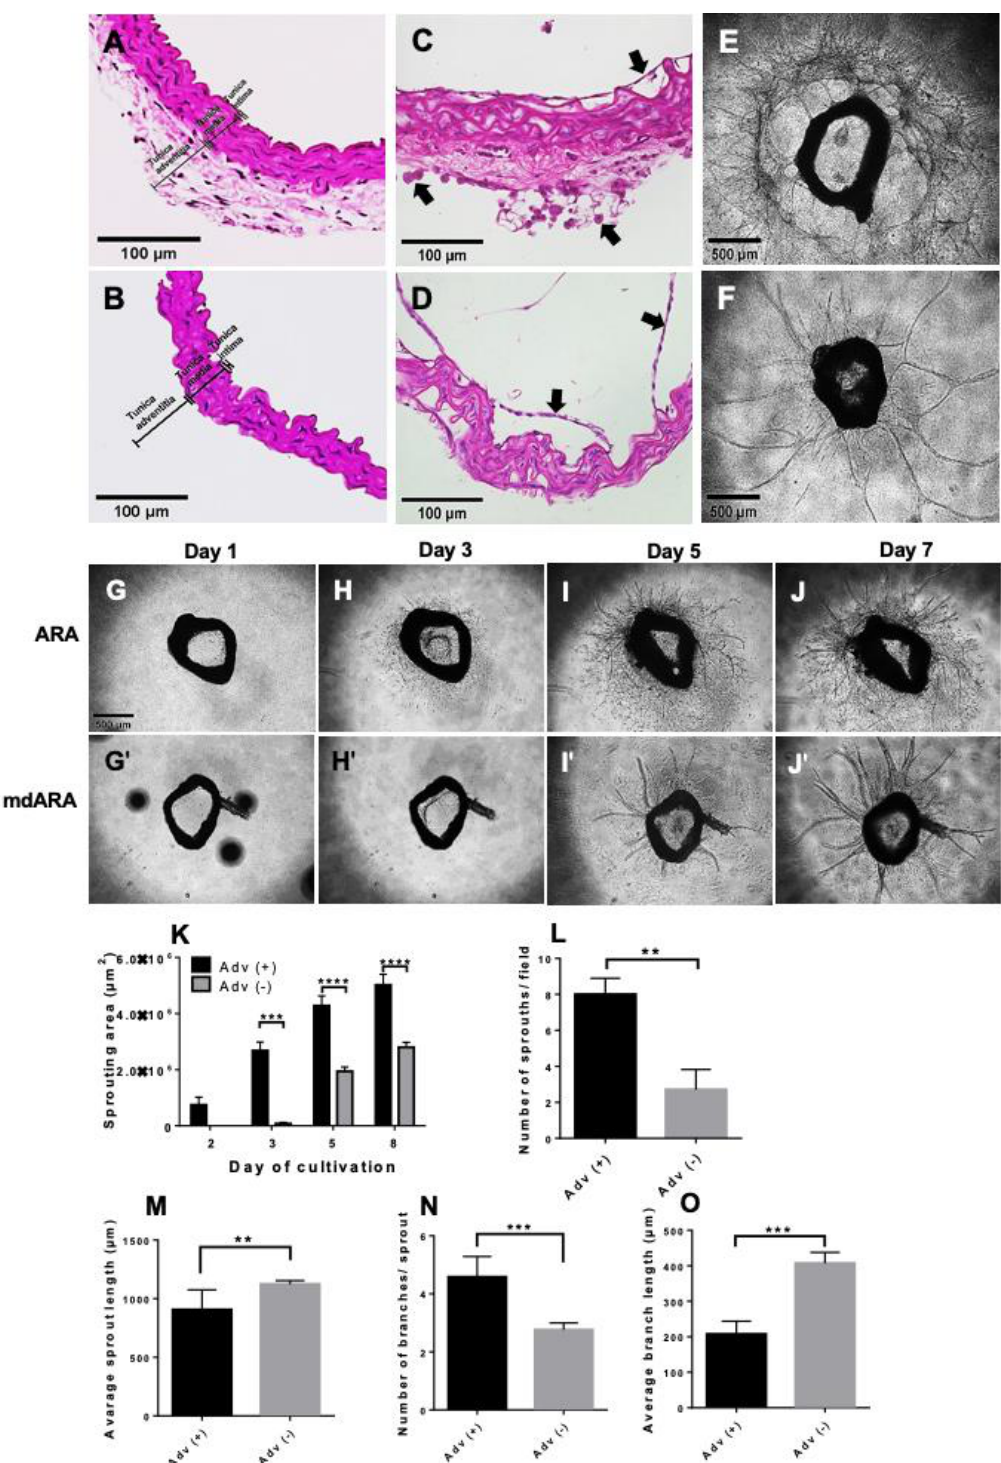
Figure 2. Removal of the adventitia delays sprouting and modulates the sprouting pattern in ARA. H&E stained paraffin sections of freshly isolated mouse aorta embedded with ( A ) and without adventitia ( B ). ARA and mdARA after 7 days of cultivation: sprouting originated from the intima, but also from the adventitia (arrows) ( C ), in mdARA only from the intima ( D ). Phase contrast images of ARA ( E ) and mdARA ( F ) after 7 days of cultivation. Time course of sprouting and branching in ARA ( G – J ) and mdARA ( G’ – J’ ). In the absence of adventitial cells, both processes are clearly delayed. Removal of the adventitia results in longer, less branched sprouts. Quantification of the sprouting area ( K ), number of sprouts/field ( L ), average sprout length ( M ), number of branches/sprout ( N ), and average branch length ( O ) in ARA and mdARA on day 8. Error bars indicate SD. ** p ≤ 0.01, *** p ≤ 0.001, **** p ≤